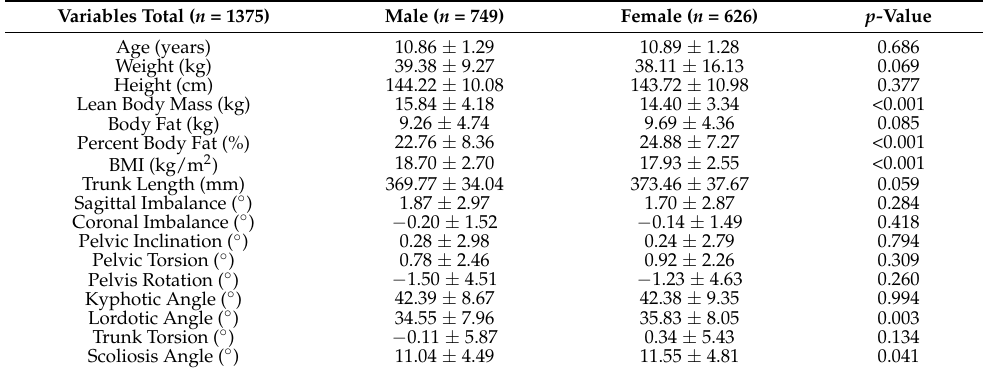
Data and abbreviations are mean ± standard deviation. Abbreviations: BMI, body mass